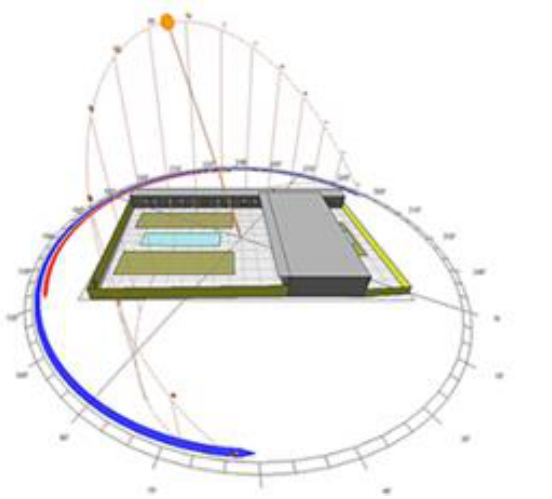
Figure 16 3D view of west wing of house No.3 in shadow (July, 11:30 am) Fig. 17 illustrates the geometry of the L-shaped courtyard house No.4, which shows its design strategies about its location, orientation and its relationship to the courtyard. The rotation degree for this house is 15° from north offset. Figs. 18 & 19 show the daily sun path and shadows for the house in the month of January and July (day 15),